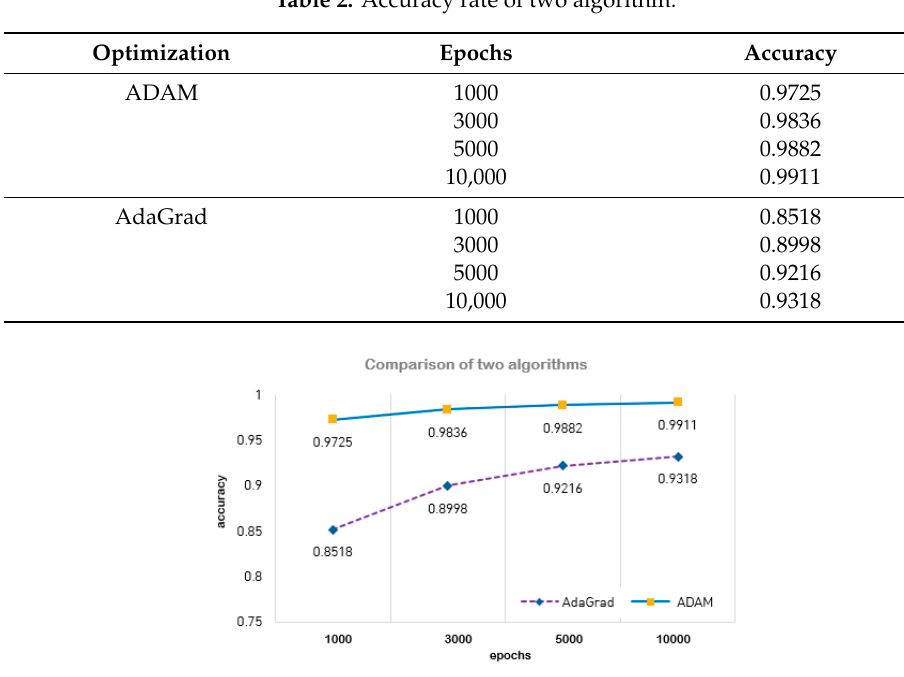
Figure 13. Experimental results: accuracy of ADAM for each epoch.